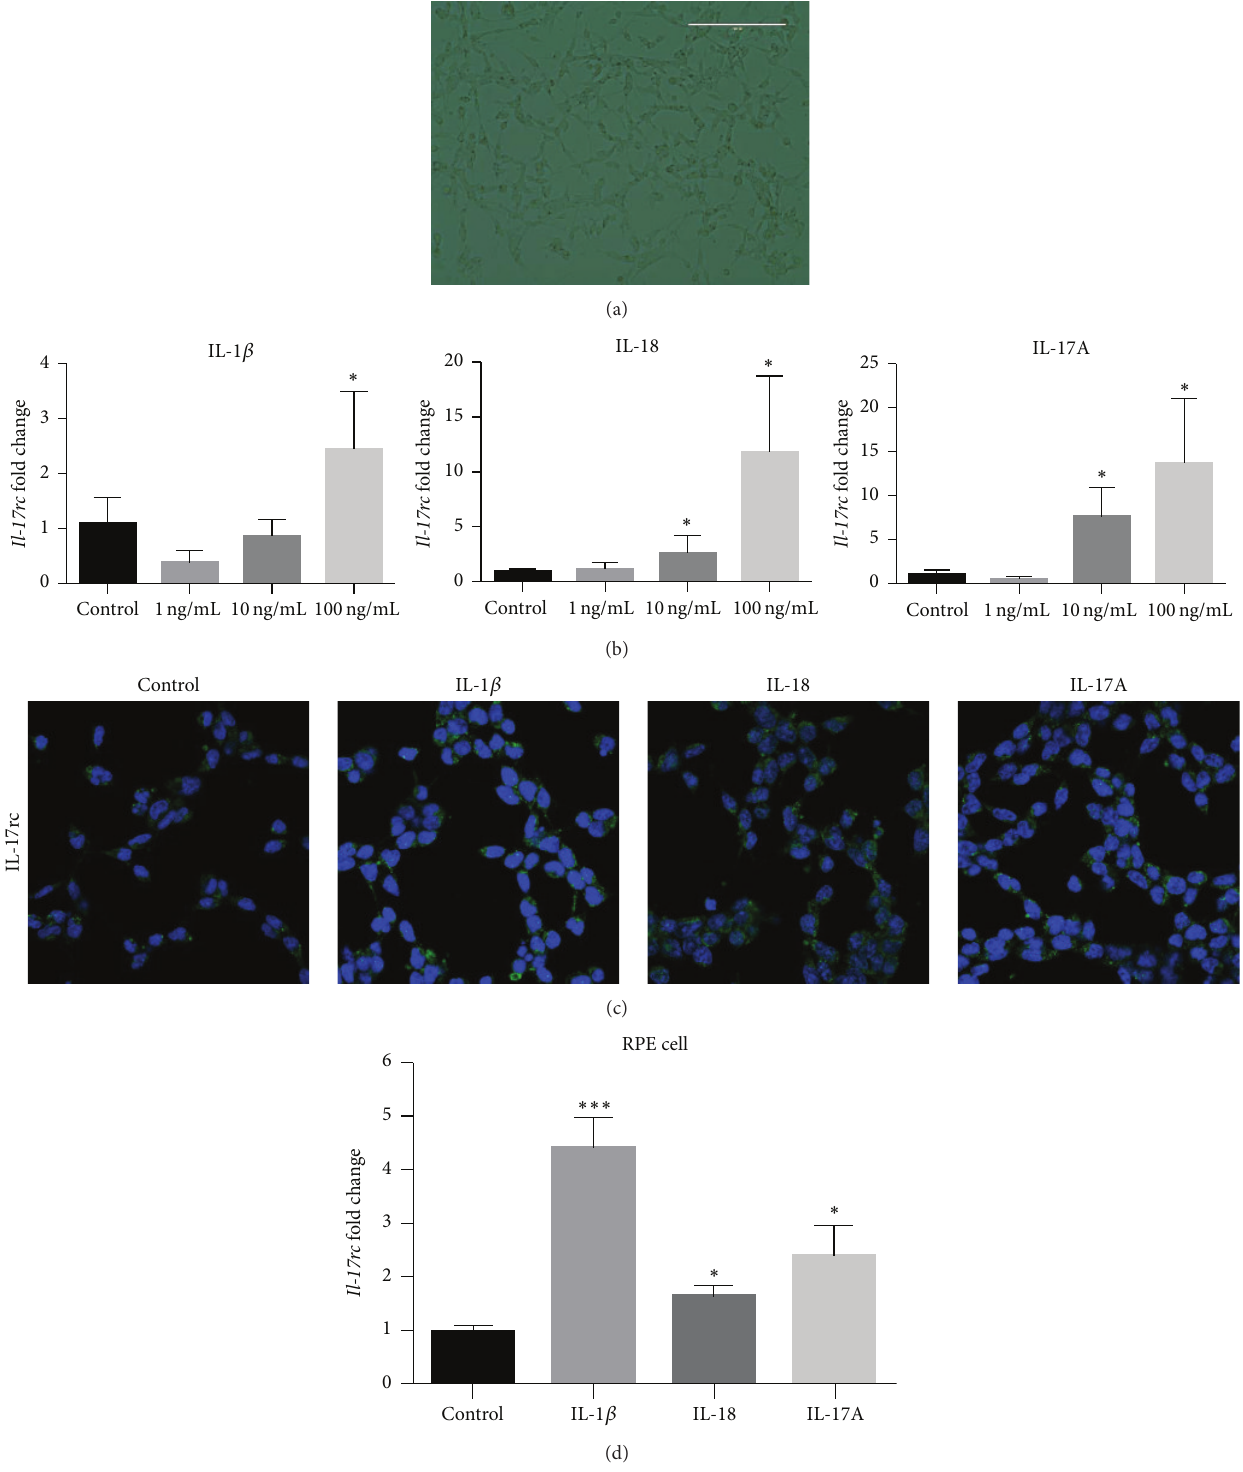
Figure 1: Morphology of the RSCs and Il-17rc expression. (a) RSCs are spindle-shaped even after passaging (scale bar: 200 𝜇 m). (b) Il-17rc mRNA was induced after the stimulation of IL-1 𝛽 , IL18, or IL-17A in a dose-dependent manner. (c) IL-17rc protein (green) is weakly expressed innonstimulatedRSCs,butmorehighlyexpressedafterstimulationwithIL-1 𝛽 (100 ng/mL),IL18(10ng/mL),orIL-17A(10ng/mL).Thenuclei were stained with DAPI (blue) (scale bar: 20 𝜇 m). (d) Il-17rc mRNA was induced after the stimulation of 100ng/mL IL-1 𝛽 , 10ng/mL IL-18, or 10ng/mL IL-17A in primary cultured mouse PRE cells. ∗ 𝑝 < 0.05 compared to control. ∗∗∗ 𝑝 < 0.001 compared to